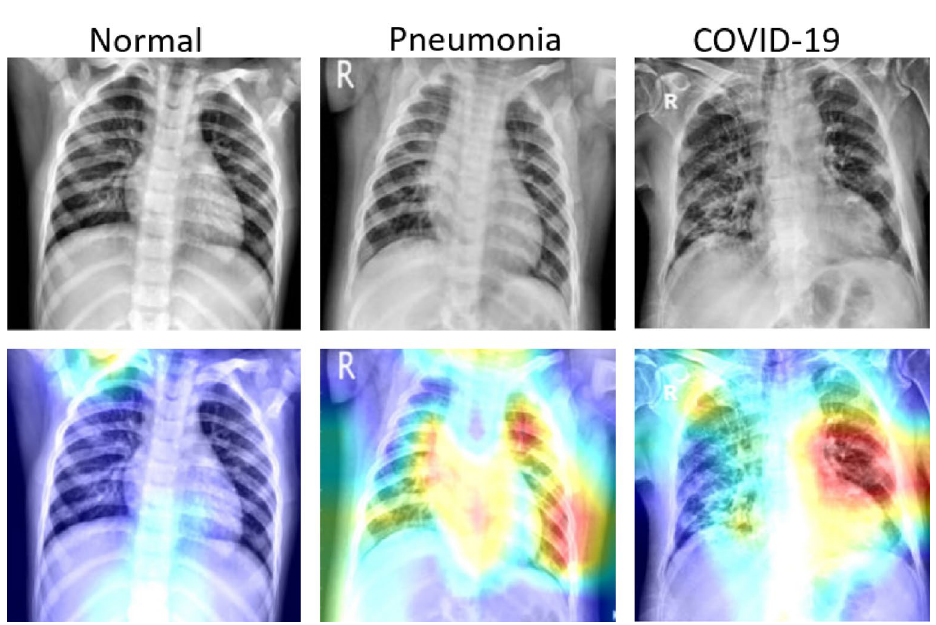
Figure 6. Gradient-based localization using Grad-CAM of Normal case, Pneumonia case, and COVID-19